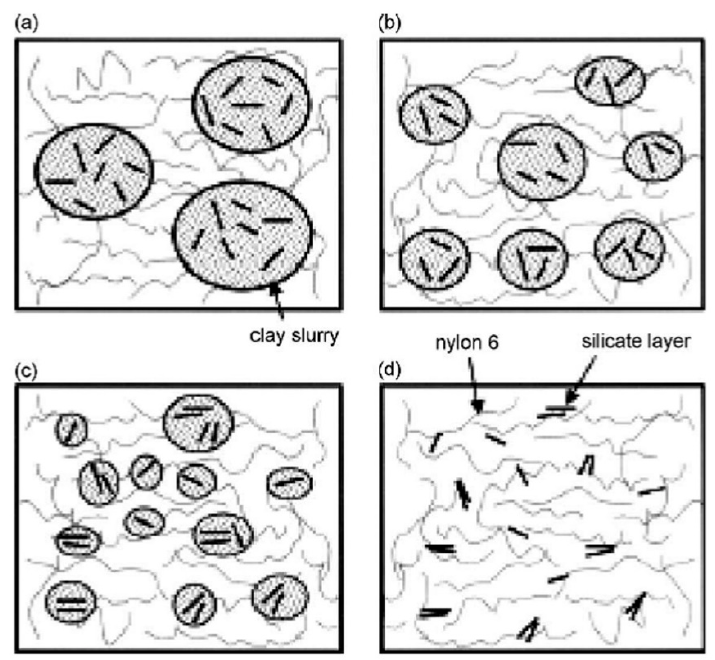
Figure 6. ( a – d ) Schematic diagrams showing dispersion of the Na-MMT silicate layers of the slurry into PA6 during compounding [108].